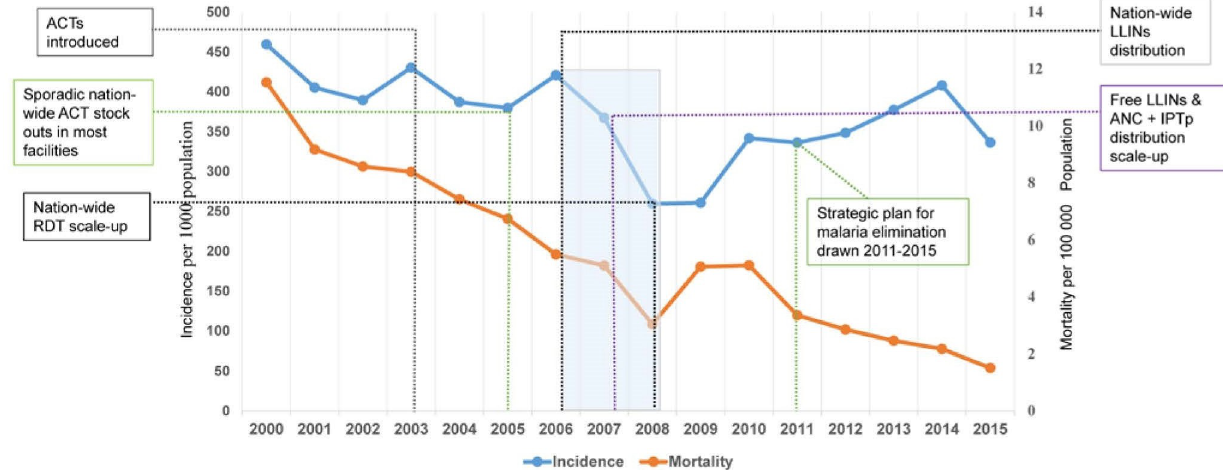
Fig 8. Incidence and mortality trend against major malaria policy changes. Significant malaria policy changes and guidelines, interventions and diagnostics in Zambia 2000–2015. Note that we did not include any changes that were progressive, e.g. IRS. Major policy changes undertaken in Zambia, 2000–2015 (Source of data: Steketee et al . 2008, Chanda et al ., 2013, Redditt et al . 2012, Kamuliwo et al . 2015 ) [2003: Chloroquine (CQ) replaced by artemisinin-lumefantrine (Coartem) as first-line malaria treatment and new diagnosis and treatment guidelines for malaria to reflect drug policy change launched; 2006: Use of Insecticide Treated Nets (ITNs) adopted; 2006–8: Training of additional microscopists, scale-up of RDTs distribution; free distribution of ITNs through antenatal care (ANC) and intermittent preventive treatment (IPT) using sulfadoxine-pyrimethamine (SP); 2011: Consideration for future elimination begins with the alignment of NMCP strategic plan 2011–2015 with the national vision “a malaria-free Zambia by 2030”